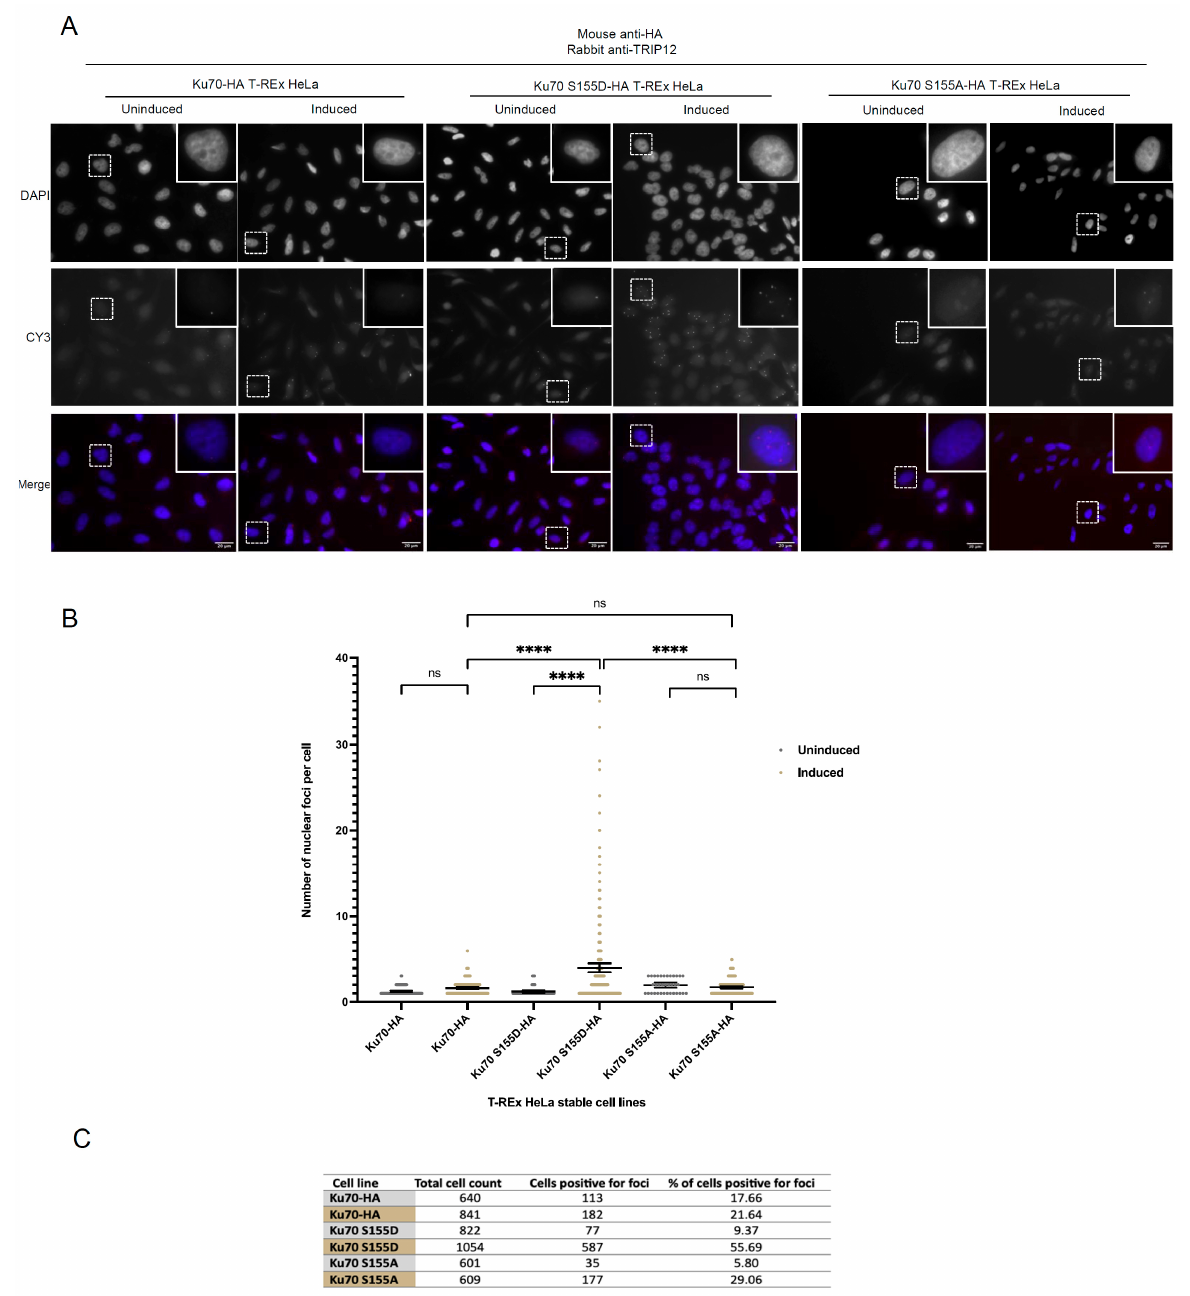
Figure 4. PLA analysis with wild-type Ku70-HA, Ku70 S155D-HA, and Ku70 S155A-HA T-REx HeLa stable cell lines and candidate protein TRIP12: ( A ) wild-type Ku70-HA, Ku70 S155D-HA, and Ku70 S155A-HA stable cell lines were induced with doxycycline (1 µg/mL) for 24 h prior to seeding and fi xing cells, then PLA was conducted using mouse MINUS and rabbit PLUS probes to determine if there was an association between Ku70 S155D-HA and the Ku70 S155D-speci fi c BioID2 candidate protein TRIP12. Images were taken at 40× magni fi cation with the white line representing 20 µm. Insets show enlargements of individual cells; ( B ) PLA quanti fi cation using ImageJ. Average number of nuclear foci determined for a minimum of 600 cells from 1–2 technical replicates (di ff erent cell passages) from four separate PLA experiments (biological replicates); only cells positive for foci are